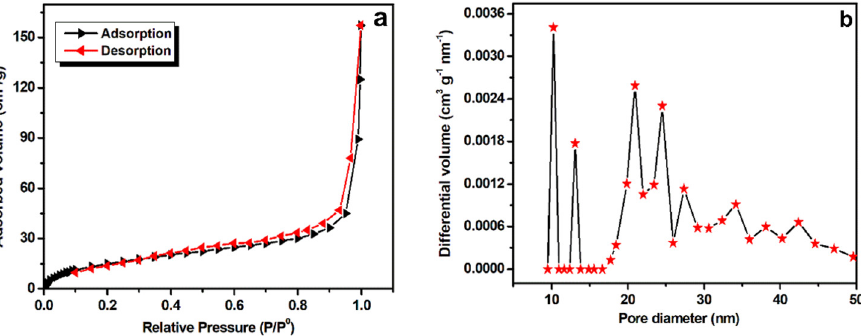
Figure 3. ( a ) BET analysis of Mn-CP and ( b ) average pore distribution calculated from BET analysis